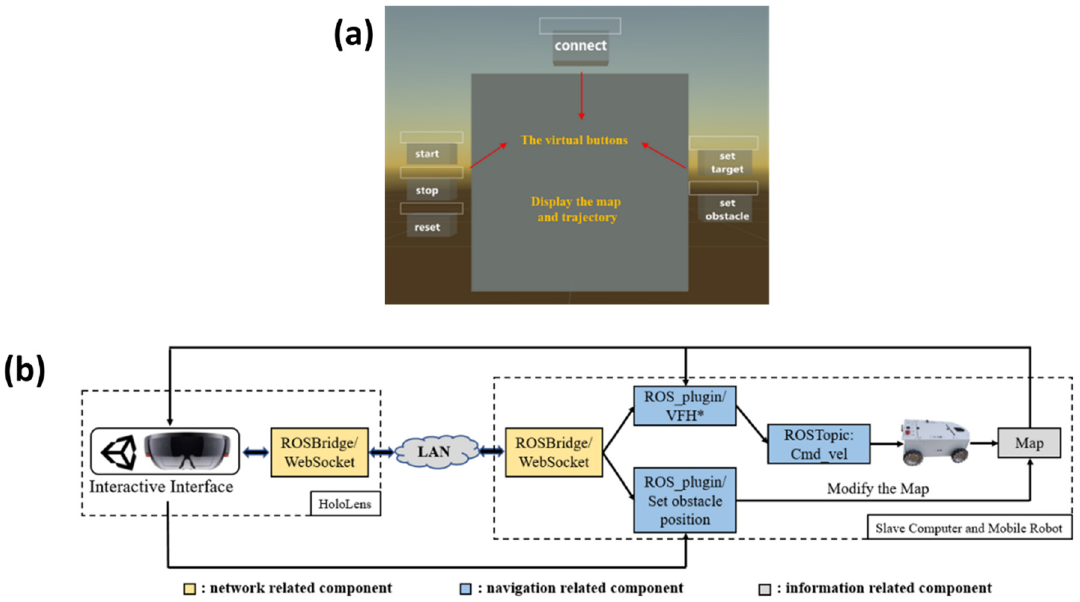
Figure 10. Control system for path planning of MR-based omnidirectional mobile robot. ( a ) Virtual panel in Unity3D. ( b ) Diagram of the software and communication layout [64].